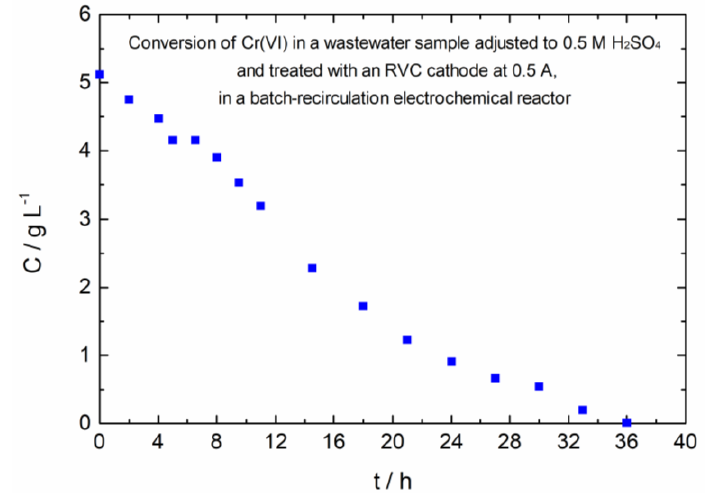
Figure 9. Concentration of Cr(VI) vs. time plots during the electrolysis of a 5.1 g · L − 1 leachate samples in a batch-recirculation type reactor, treating 800 mL with a 33 L · h − 1 flow rate, using an RVC cathode electrode and a constant current of 0.5 A.